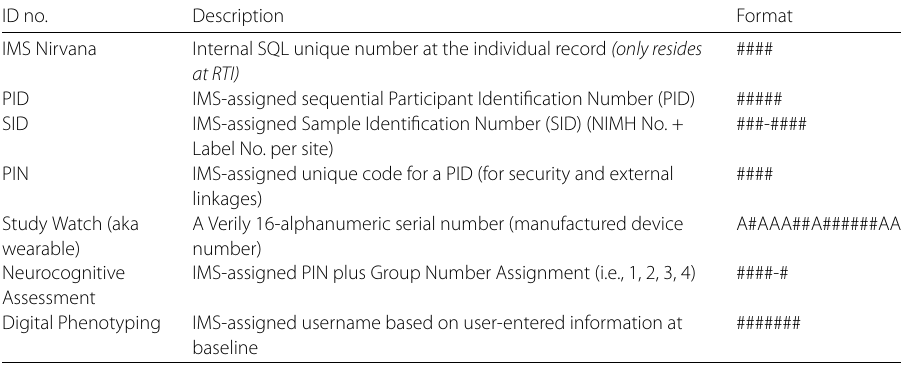
Table 2 Illustrative big data linkage identification scheme ID no. Description IMS